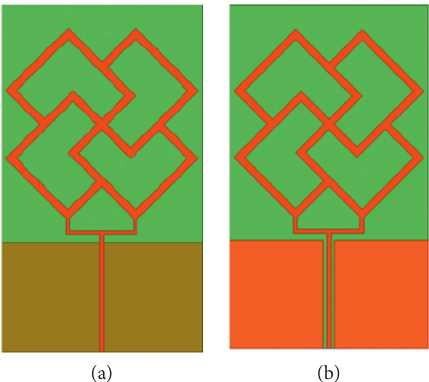
Figure 9: Comparison of power feeding methods. (a) Microstrip line structure. (b) Coplanar waveguide structure.